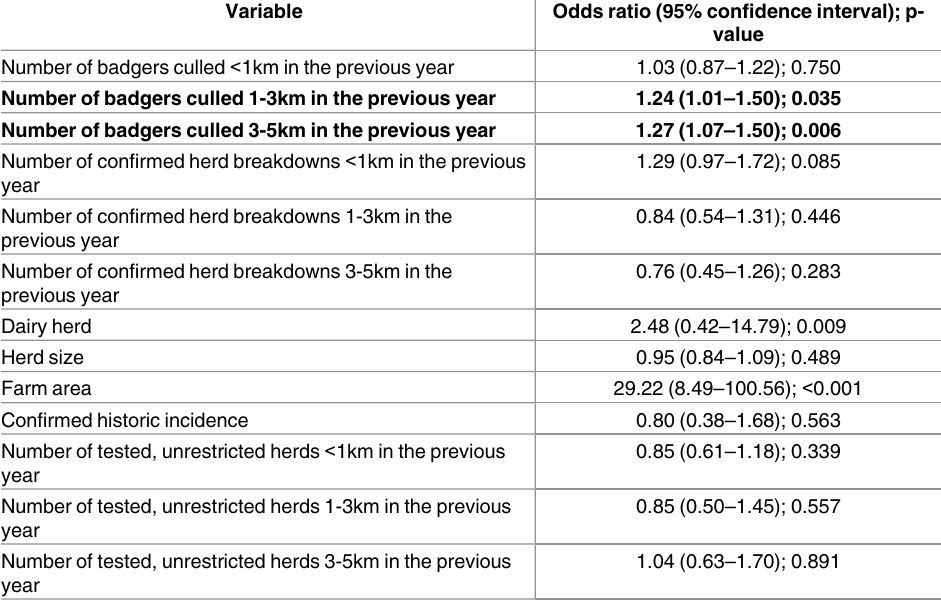
Table 3. Results of models investigating associations between herd-breakdowns and the number of RBCT culled badgers within the previous year, including data at all three distances simultaneously, while adjusting for confirmed herd breakdowns and other herd-levels covariates. Estimated odds ratios and their confidenceintervals correspondto the changein risk of herd breakdownassociated with a doublingof that variable. Negative log likelihoodof the model = 91.22, d.f. =